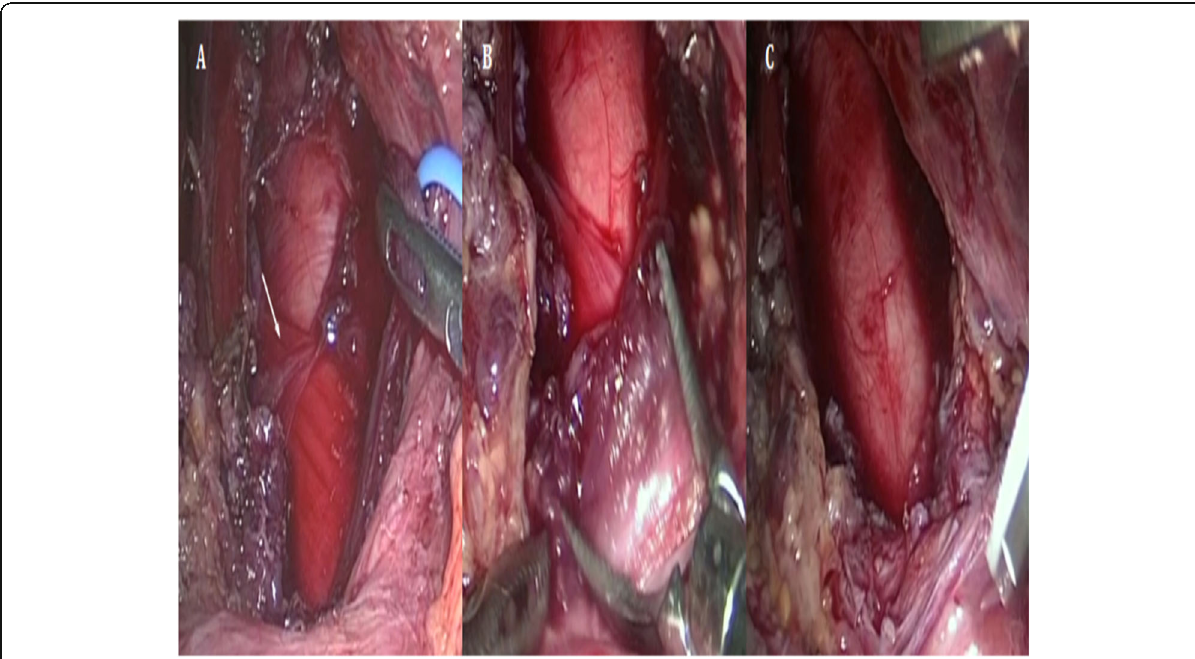
Fig. 2 Intraoperative image of the same case in Fig. 1 with median arcuate ligament syndrome. The median arcuate ligament is first identified ( a ) and is dissected bluntly to release ( b and c ) the pressure on the celiac trunk